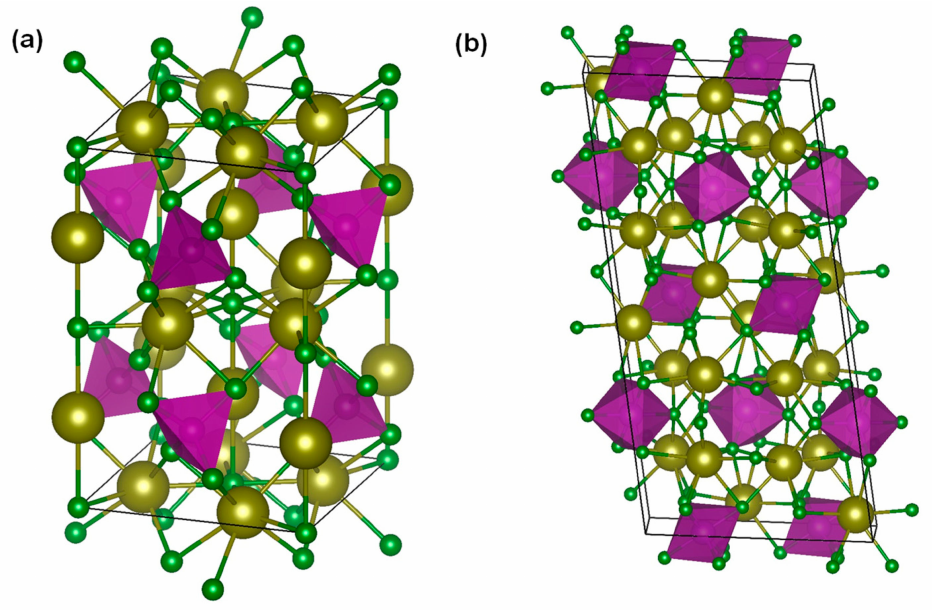
Figure 1. Crystal structure of electronically zero-dimensional with the isolated ( a ) tetrahedral and ( b )